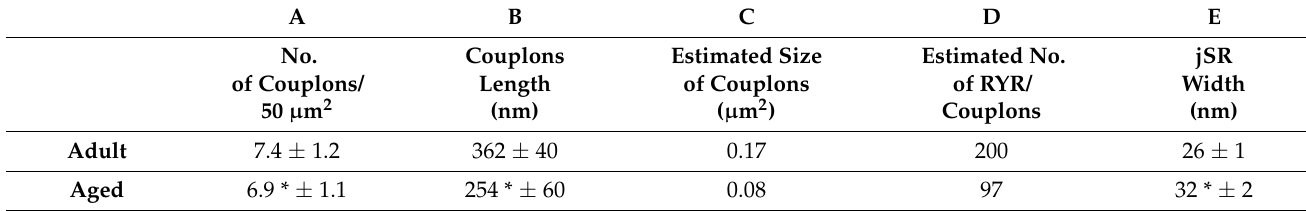
Table 2. Quantitative analyses of number and size of